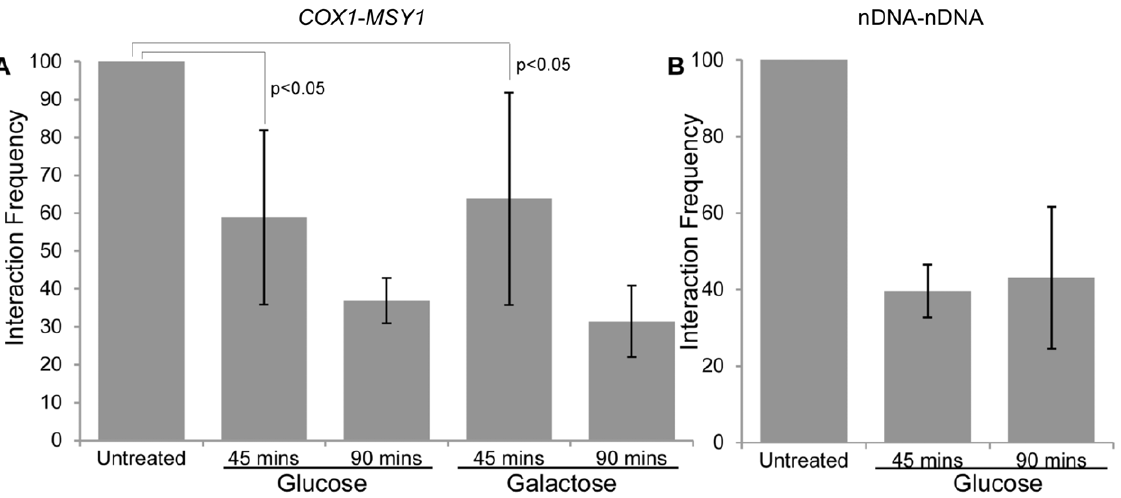
Figure 3. A functional electron transport chain is required to maintain the interaction between the mitochondrial COX1 and nuclear MSY1 loci. Uncoupling of the electron transport chain was achieved by 2,4-dinitrophenol (5 mM) treatment of exponentially growing S. cerevisiae in synthetic complete media, containing glucose or galactose, for the indicated time (Figure S4). COX1-MSY1 A) and nDNA-nDNA B) interaction frequencies were determined by quantitative 3 C analyses using fluorescent probes (see Methods S1). Interaction values in A) were corrected for mitochondrial genome copy number while those in B) were corrected for nuclear genome copy number (see Methods). Interaction values were expressed as percentages of the untreated sample (set at 100%) + / 2 standard error of the mean